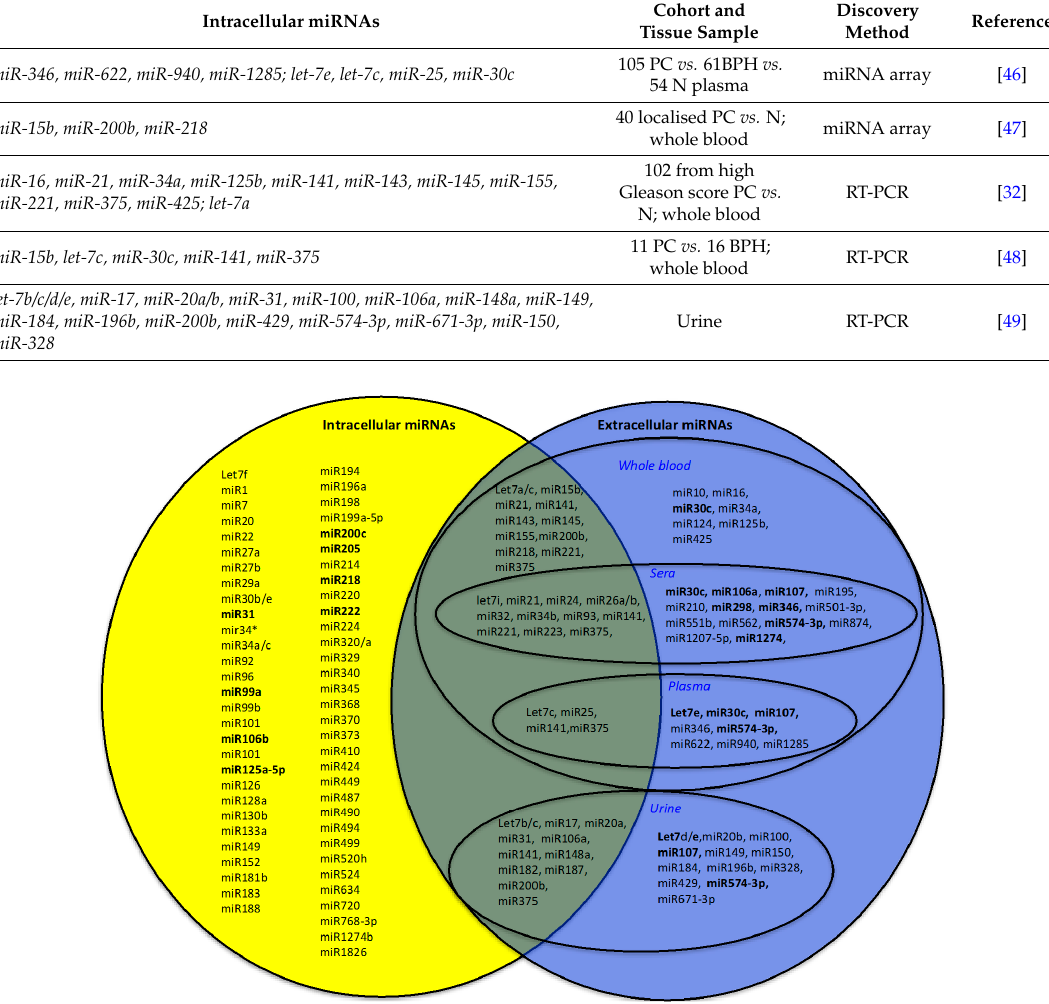
Figure 2. Venn diagram: extracellular and intracellular diagnostic miRNAs in PC. In bold: miRNAs altered in more than one signature. At the intersection of the sets: miRNAs in common among extracellular and intracellular diagnostic miRNAs.